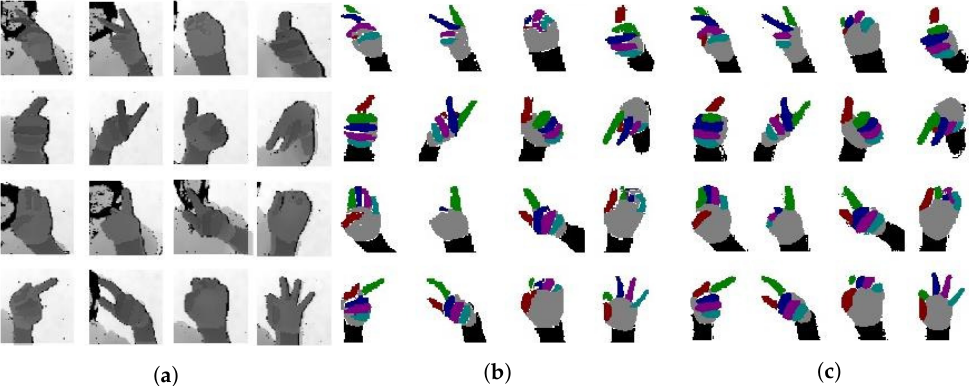
Figure 12. Results of hand component segmentation using the Seresnext backbone with the ground-truth depth ( a ), ground-truth labels ( b ), and Seresnext ( c ).